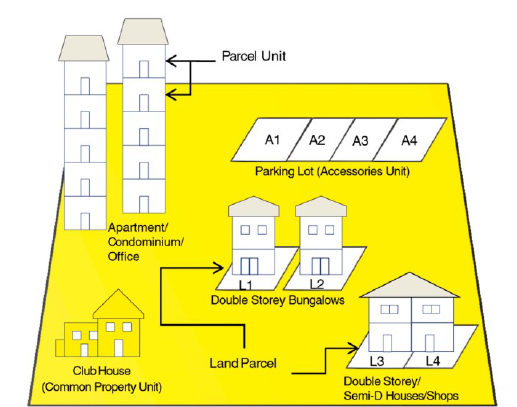
Figure 1 . The cadastral objects related to strata in one lot (courtesy of JUPEM).